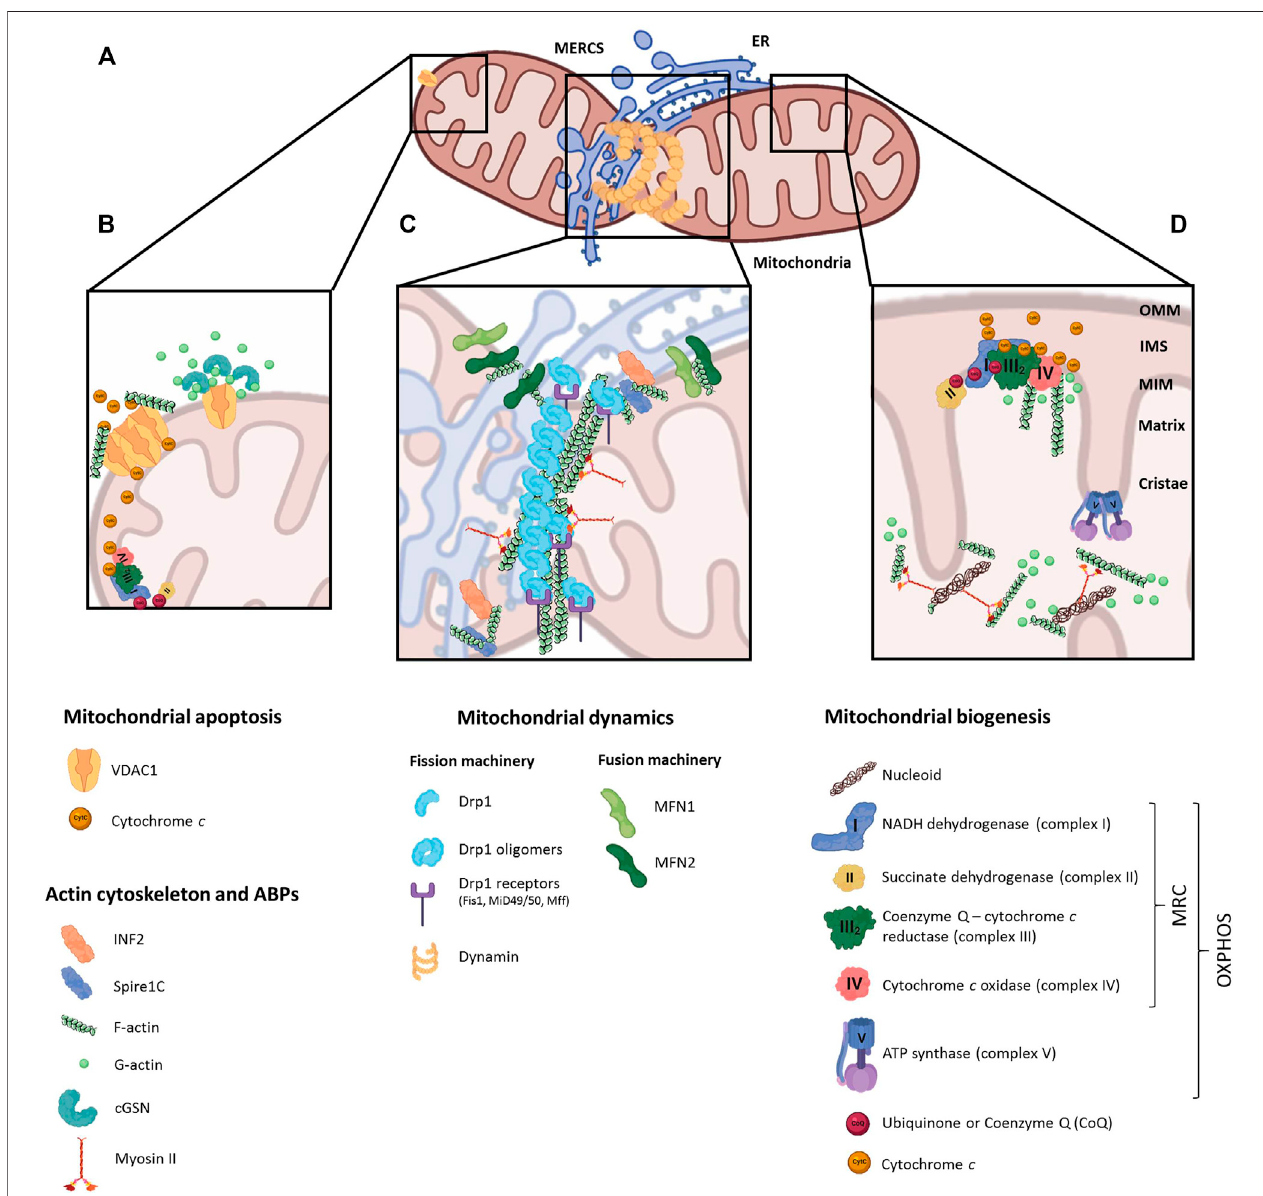
FIGURE 1 | Regulatory roles of actin cytoskeleton on mitochondrial function. (A) Schematic representation of a mitochondrion interacting with the endoplasmic reticulum(ER)atmitochondrial-endoplasmicreticulumcontactsites(MERCS),wheredynaminisrecruitedand fi ssioneventstakeplace. (B) Underanti-apoptoticstimuli, actin-binding proteins interact with the voltage-dependent anion channel 1 (VDAC1) in the outer mitochondrial membrane (OMM), preventing actin fi laments oligomerization and apoptosis; conversely, actin polymerization favors VDAC oligomerization and induces the apoptotic pathway. (C) Actin cytoskeleton is representedatMERCS,togetherwithABPs(INF2,Spire1C)andOMMproteinsinvolvedinmitochondrialdynamics(MFN1/2).ActinandmyosinIIlocalizationatMERCSs initiatesDrp1recruitment, whichbindingtoDrp1receptors (Fis1,MUD49/50,MFF)leadstomitochondrial fi ssion. (D) Actininteractswithmitochondrialrespiratorychain (MRC) complexes III and IV in the matrix, controlling the association and dissociation of cytochrome c ; and together with myosinII, actin regulates the distribution of mitochondrial nucleoids.